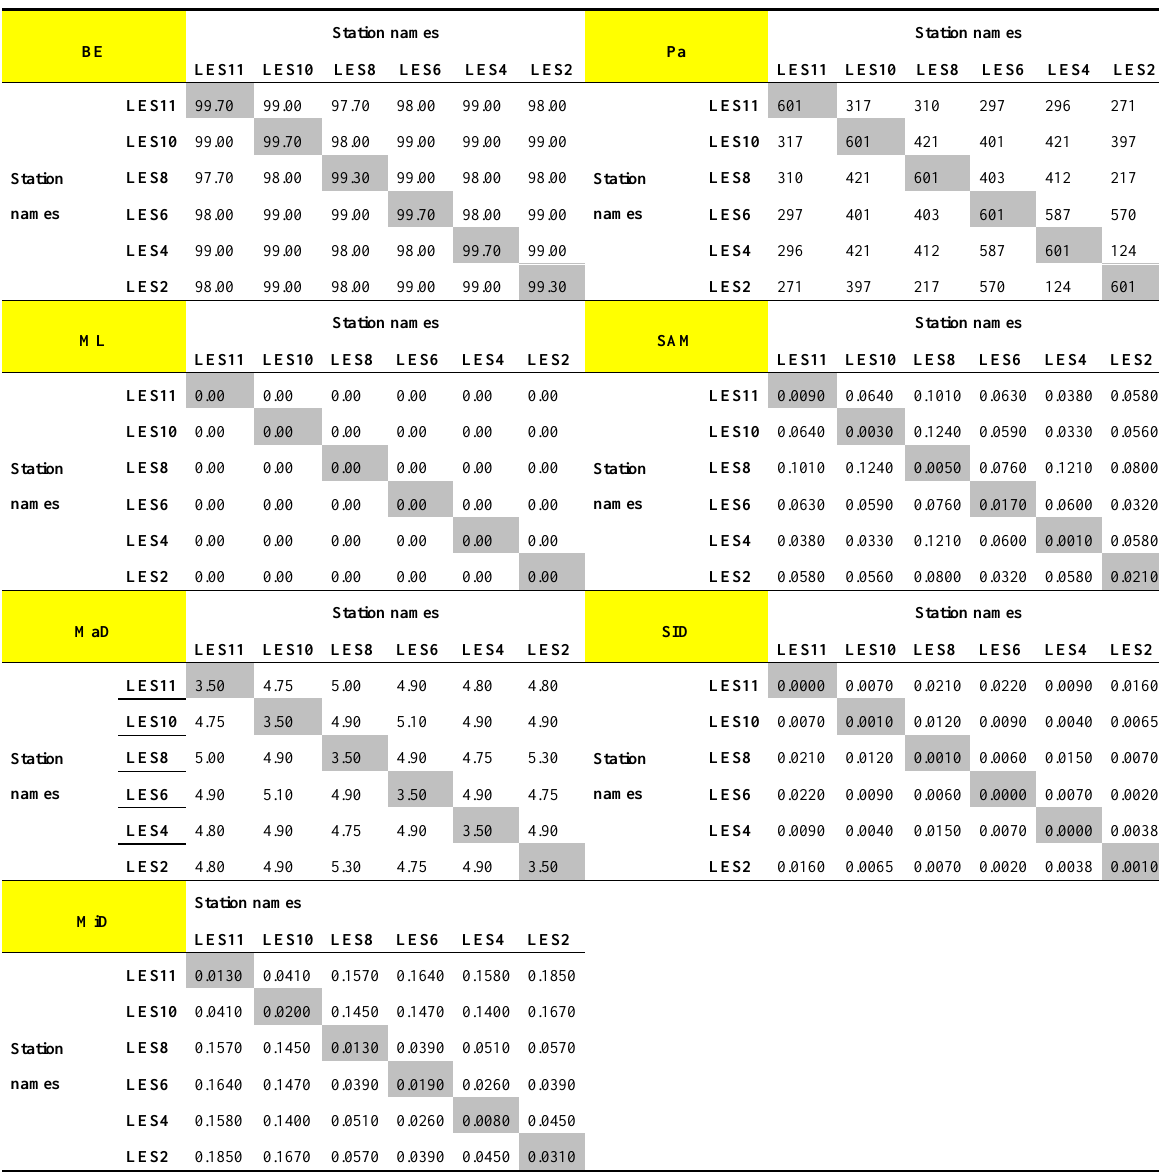
Table 3. The seven Spectral Similarity Matrices of the PRISMA data, obtained by the seven supervised classifiers which were performed on the coastal waters of the area close to Lagoon of Lesina are shown. The names of the algorithms are shown in the first row of the first column of each Spectral Similarity Matrix, highlighted in yellow. Each Spectral Similarity Matrix is symmetrical with respect to the main diagonal, highlighted in grey. The first row and the first column of each Spectral Similarity Matrix show the station names (see